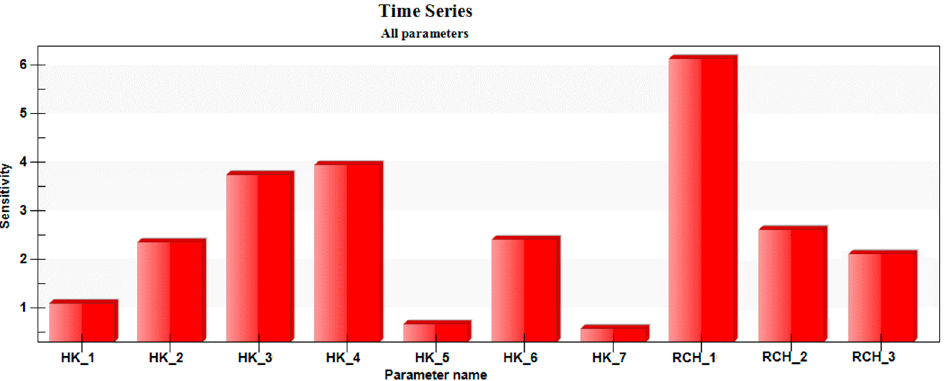
Figure 12. Sensitivity analysis of modeling